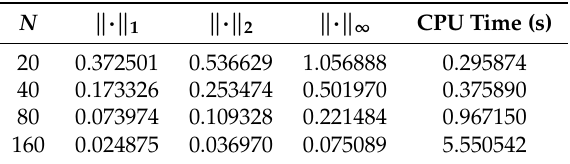
Table 6. Error table using WENO-FDM for the approximate solution p ( v , t ) graphically represented in Figure 4, at a final time t = 0.00255 with the finest grid being N ∗ = 320.